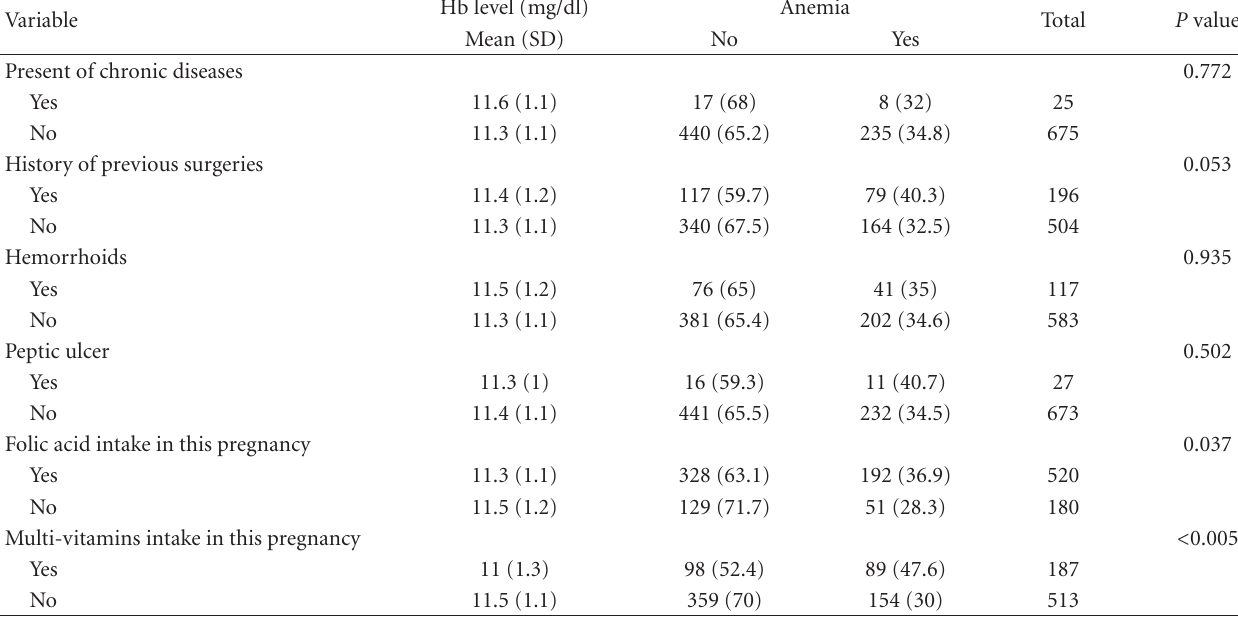
Table 4: Prevalence of anemia according to medical characteristics.